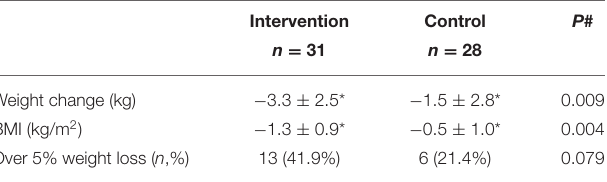
TABLE 3 | Weight changes after 12 weeks of follow-up.